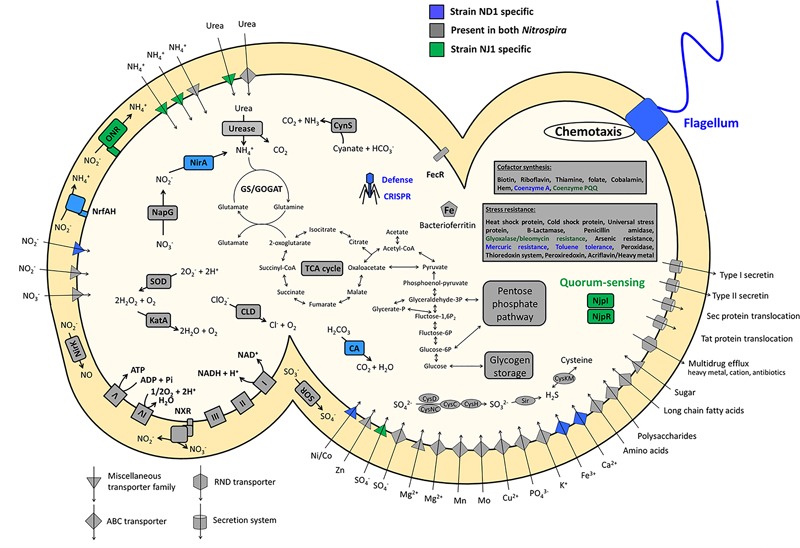
Schematic representation of a cell showing the key and unique metabolic features encoded by the genomes of strains ND1 and NJ1. Core functions shared between the two Nitrospira isolates are shown in gray, specific features of strain ND1 are shown in blue, and those of strain NJ1 are shown in green. CA, carbonic anhydrase; CLD, chlorite dismutase; CRISPR, clustered regularly interspaced short palindromic repeats; CynS, cyanase; GS/GOGAT, glutamine synthetase/glutamate synthase (glutamine oxoglutarate aminotransferase); KatA, catalase; NapG, nitrate reductase; NirA, ferredoxin-nitrite reductase; NirK, copper-containing nitrite reductase (forming NO); NjpI, autoinducer synthase; NjpR, autoinducer receptor; NrfAH, cytochrome c nitrite reductase; ONR, octaheme cytochrome c nitrite reductase; SOR, cytochrome c sulfite oxidoreductase; SOD, superoxide dismutase. Enzyme complexes of the electron transport chain are labeled by Roman numerals. The TCA cycle depicts both directions.